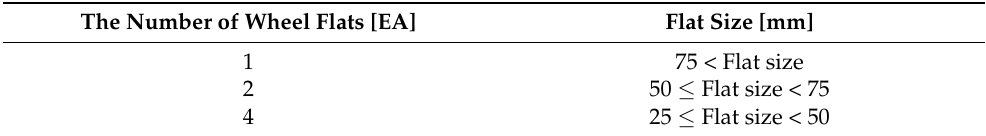
Figure 1. Wheel Flat. Table 1. Safety standards for domestic urban railway vehicles.